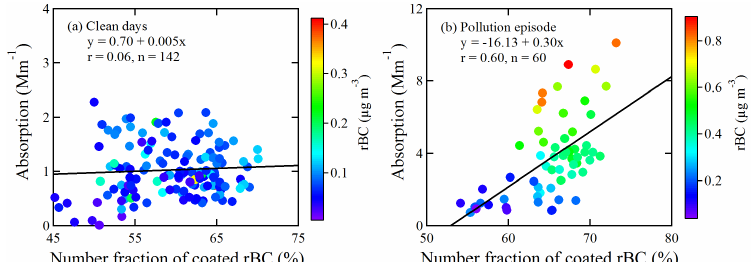
Figure 8. Light absorption as a function of number fraction of coated rBC during (a) clean days and (b) the pollution episode. Data points are color-coded for rBC mass